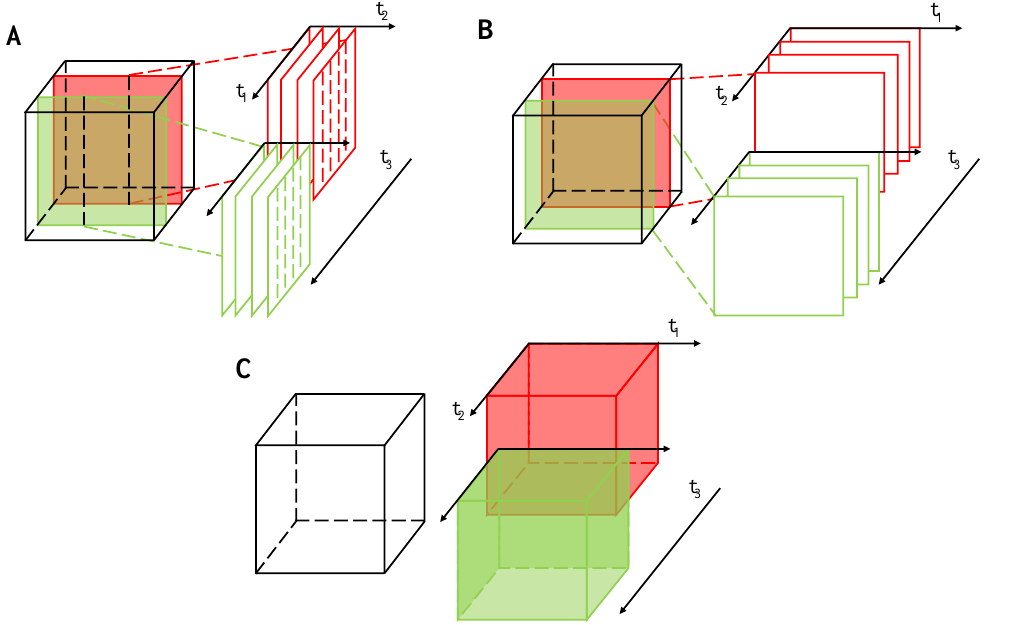
Figure 10. Volumetric OCTA scanning protocols can operate with respect to A-scan ( A ), frame ( B ), or volume ( C ). A cubic volume is scanned with time scales t 1 , t 2 , and t 3 . Data acquired sequentially along time scale t 3 are shown in red and green. ( A ) MB-scan: multiple A-scans are obtained at one lateral position before switching to the next lateral position; ( B ) BM-scan or interframe scan: multiple B-scans are obtained at one cross-sectional location before switching to the next location; ( C ) intervolume scan: successive scans of the whole volume. Each scan achieves a progressively larger observation time for a single spatial position (t 3 > t 2 > t 1